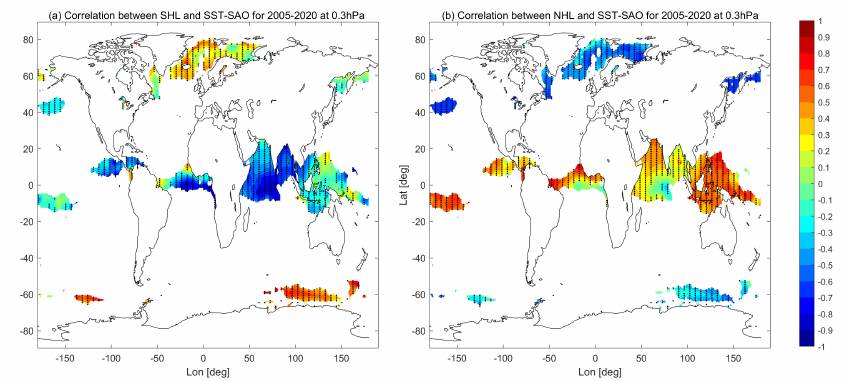
Figure 9. The correlation between MLS temperature SAO signal at 0.3 hPa averaged around the SH high latitudes (58 ◦ S–70 ◦ S) ( a ), the NH high latitudes (70 ◦ S–82 ◦ S) ( b ) and SST-SAO. The dots mark the significant area at 95%